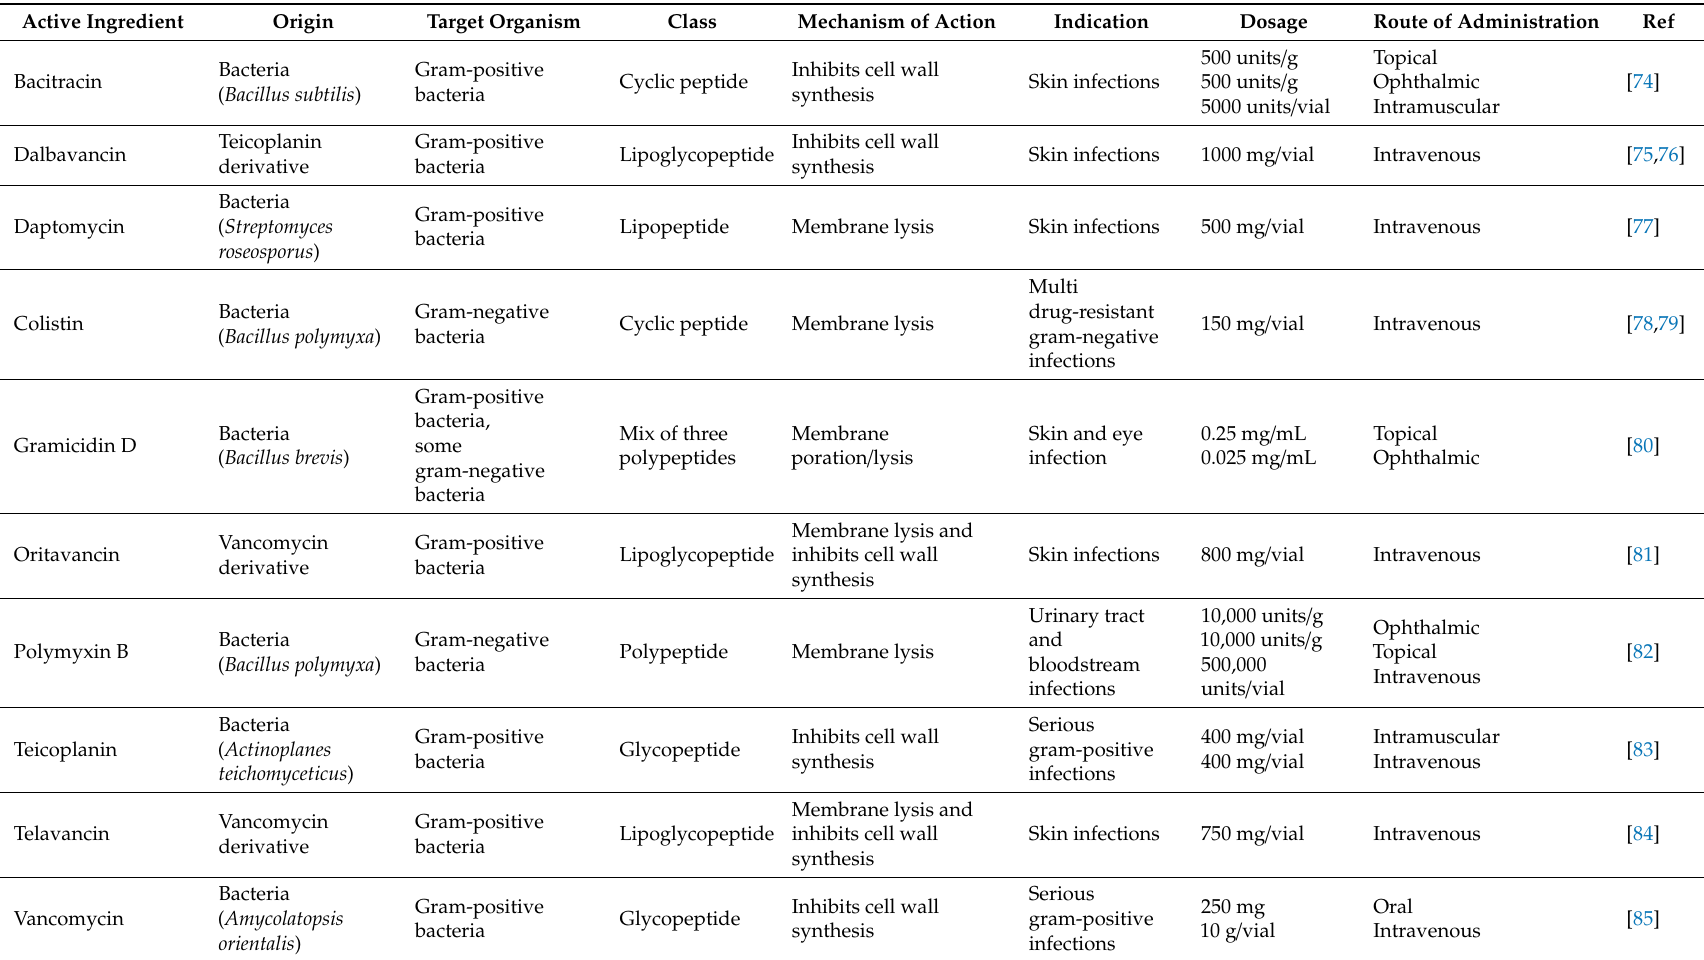
Table 1. Commercially available peptide-based